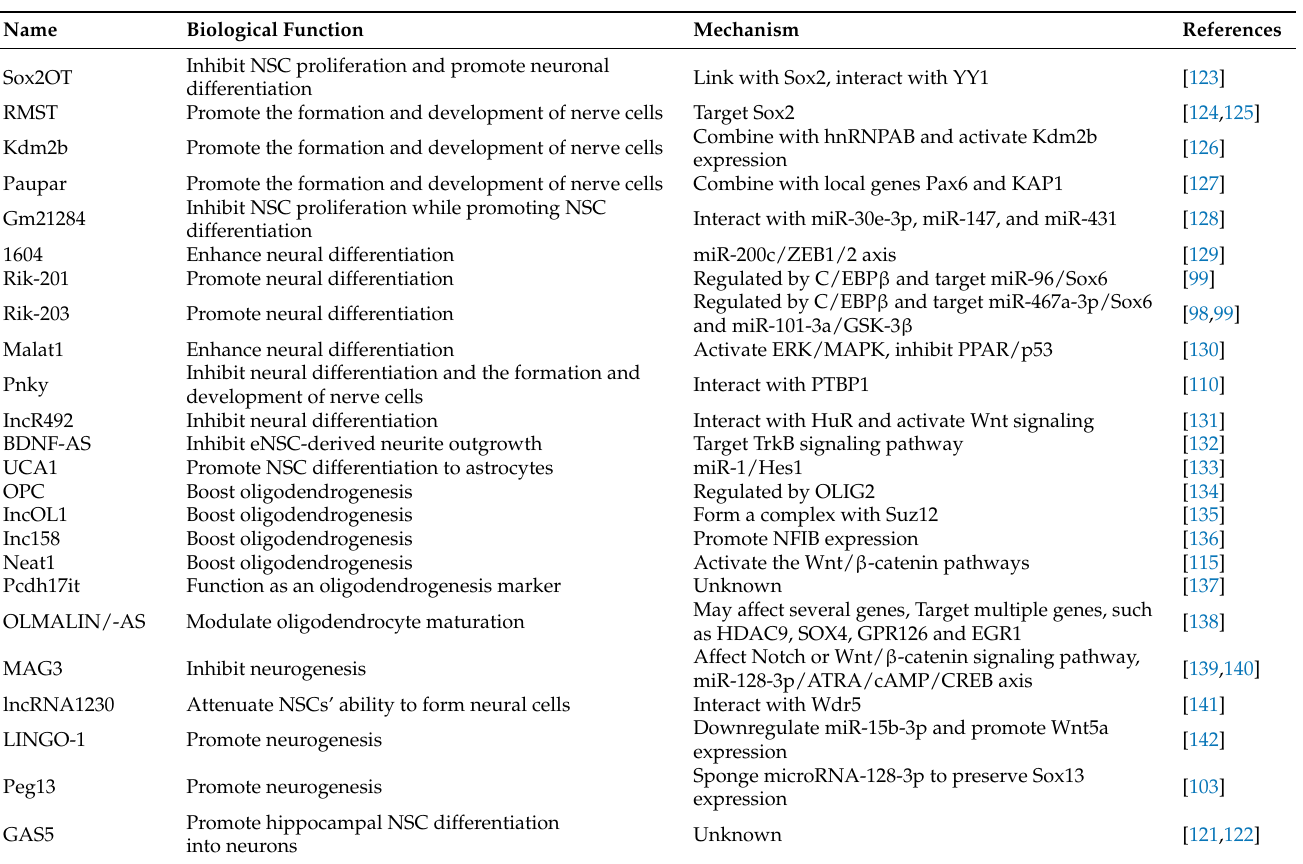
Table 2. Effects and mechanisms of various lncRNAs on